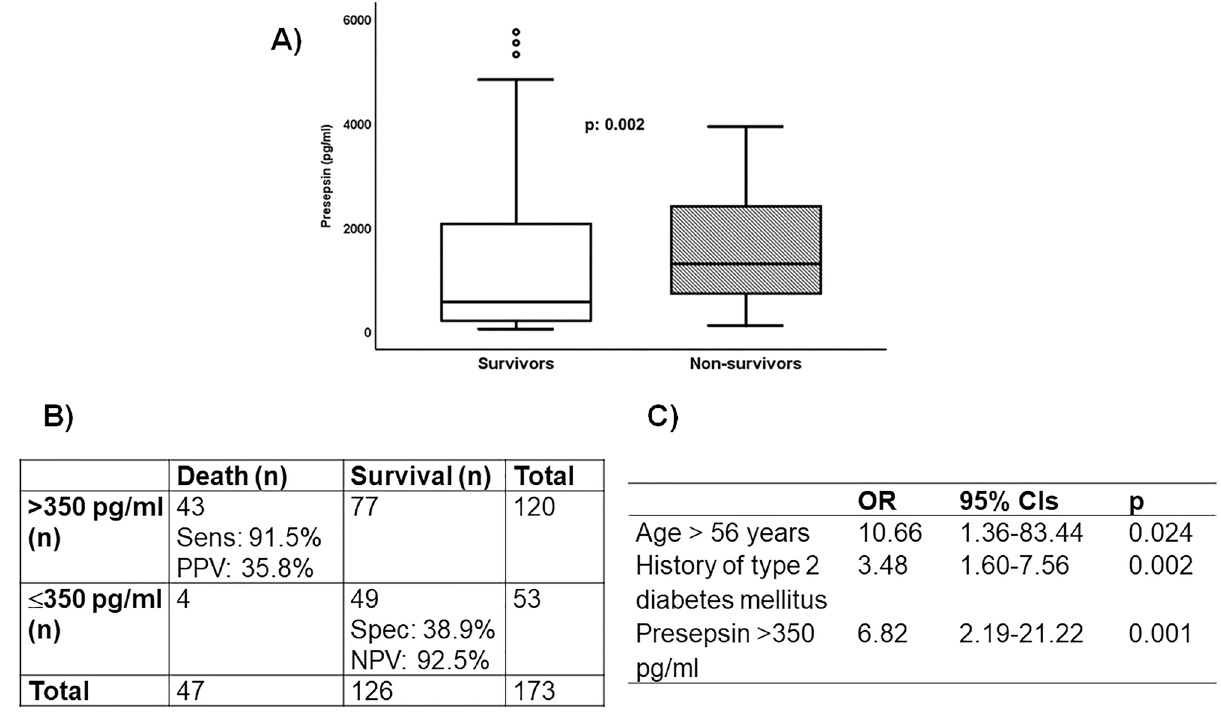
Figure 3. Prognostic performance of presepsin for 28-day mortality in the derivation cohort. ( A ) Box plots of the concentrations of presepsin between survivors and non-survivors. The p-value of the comparison